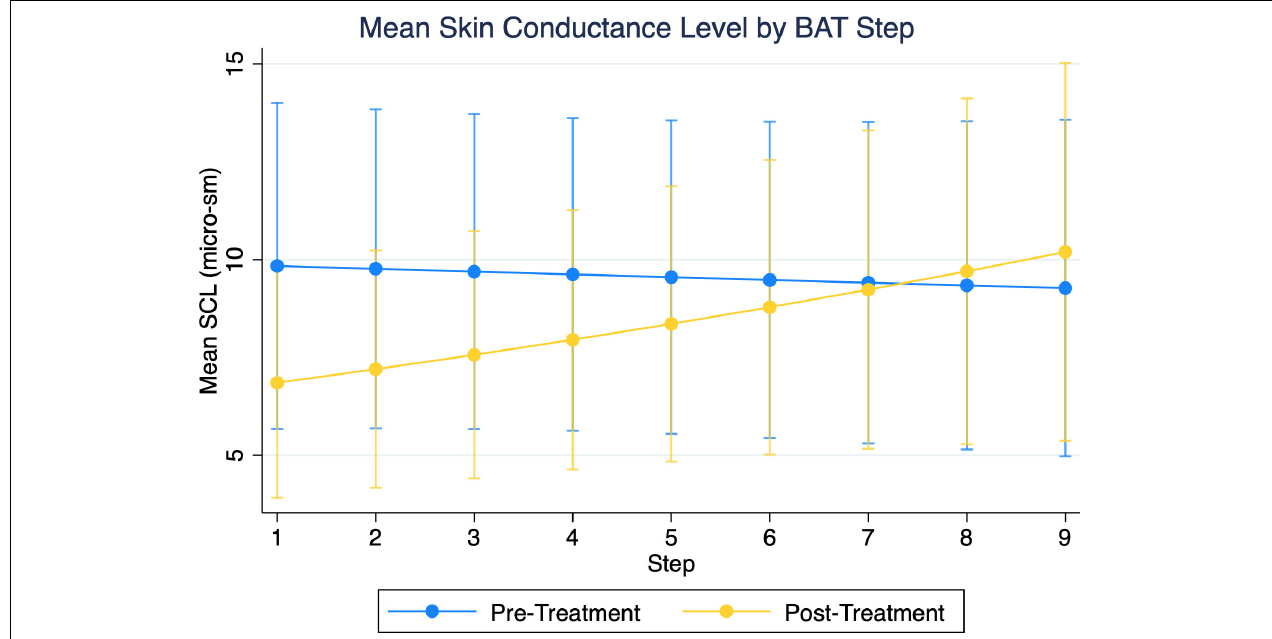
FIGURE 6 | Depiction of two-variable multi-level models of skin conductance level (SCL), as a function of step and timepoint. Initial three-variable model including group were found not to have significant three-way interaction.